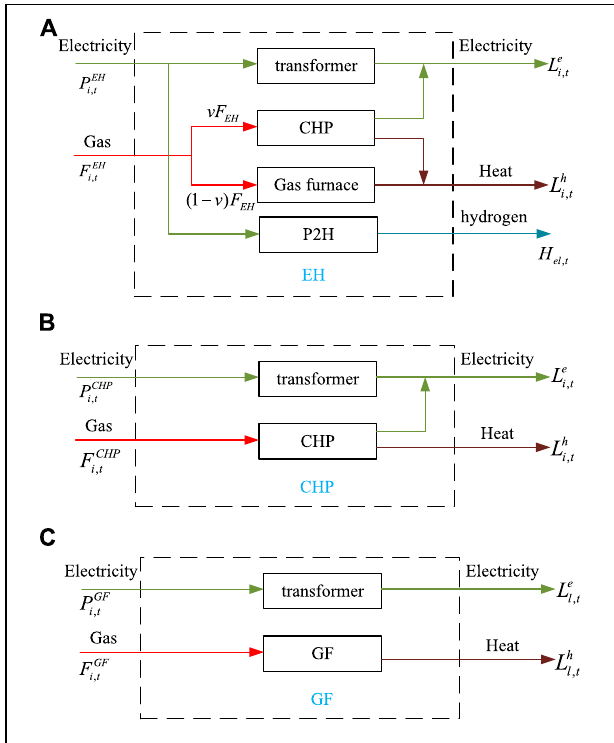
FIGURE 2 | Components of the energy hub.